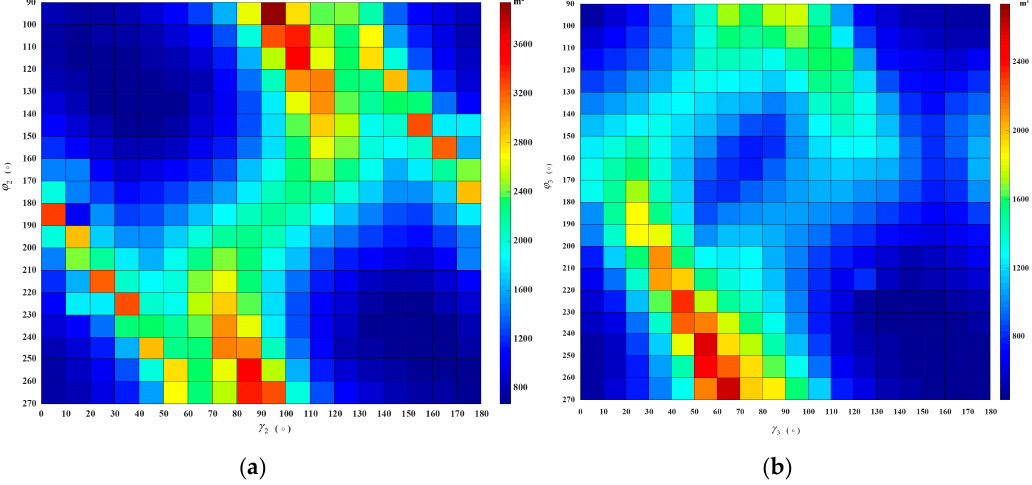
Figure 5. Simulated multi-satellite fusion MPSF: ( a ) A 1 ( 180 ◦ ,90 ◦ ,45 ◦ ) + A 2 ( 100 ◦ ,50 ◦ ,45 ◦ ) , Figure 6. Two-dimensional (2-D) resolution unit area distribution of the Multi-Satellite Fusion Point Spread Function (MPSF): ( a )